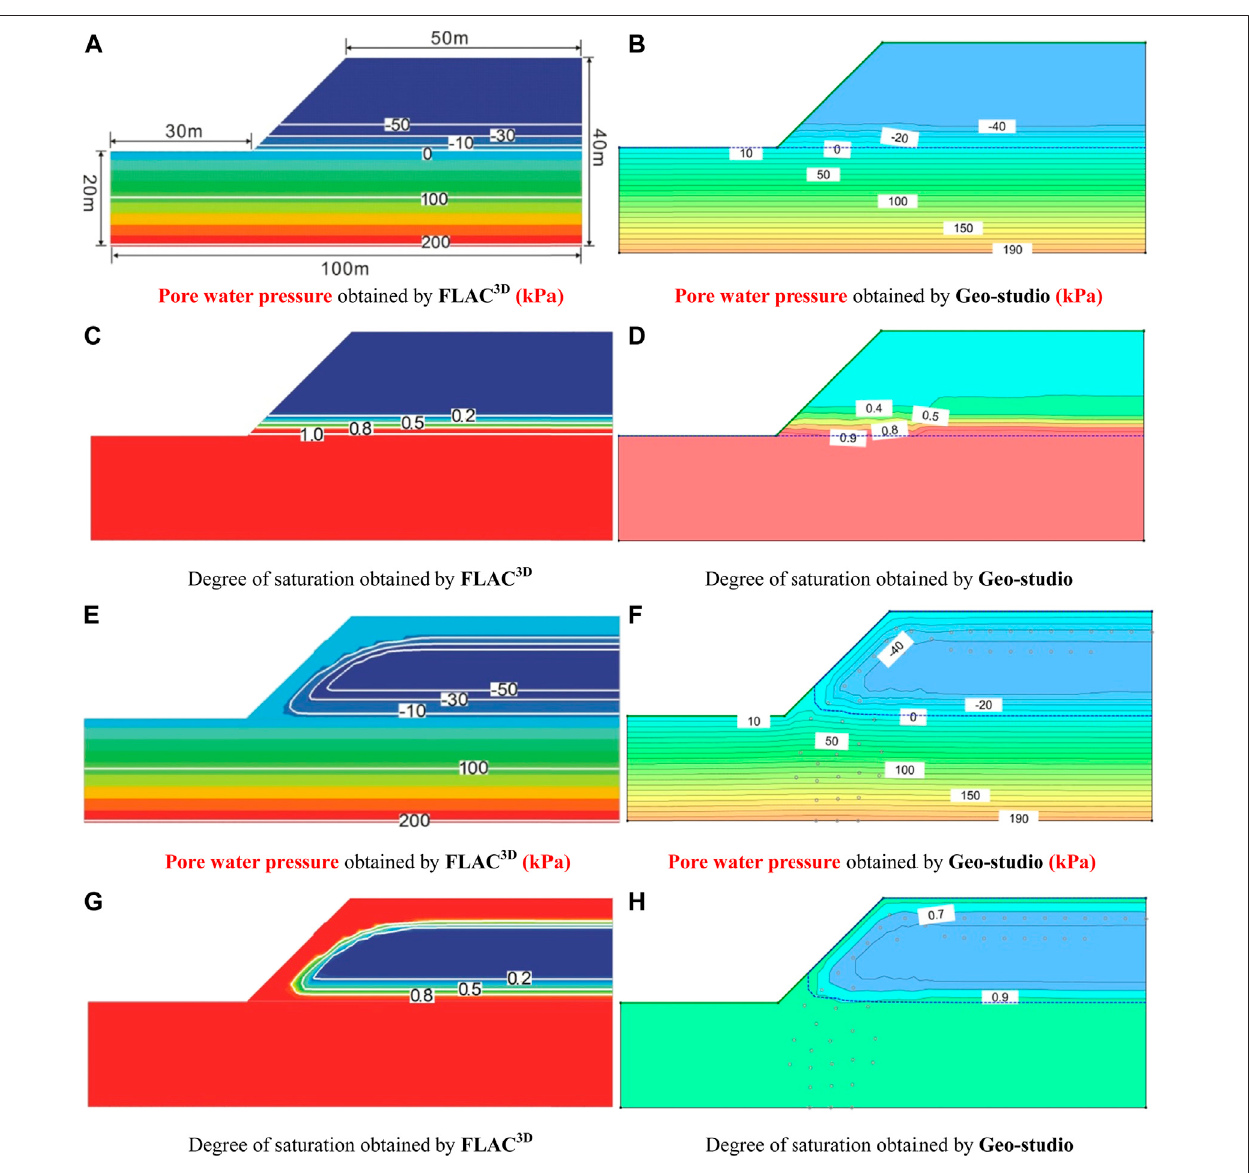
FIGURE 2 | Distributions of pore water pressure and saturation under different conditions obtained by using FLAC3D and Geo-studio: (A) Pore water pressure before raining, (B) Pore water pressure before raining, (C) Degree of saturation before raining obtained, (D) Degree of saturation before raining, (E) Pore water pressure after rainfall last 84 h, (F) Pore water pressure after rainfall last 84 h, (G) Degree of saturation after rainfall last 84 h, (H) Degree of saturation after rainfall last 84 h.